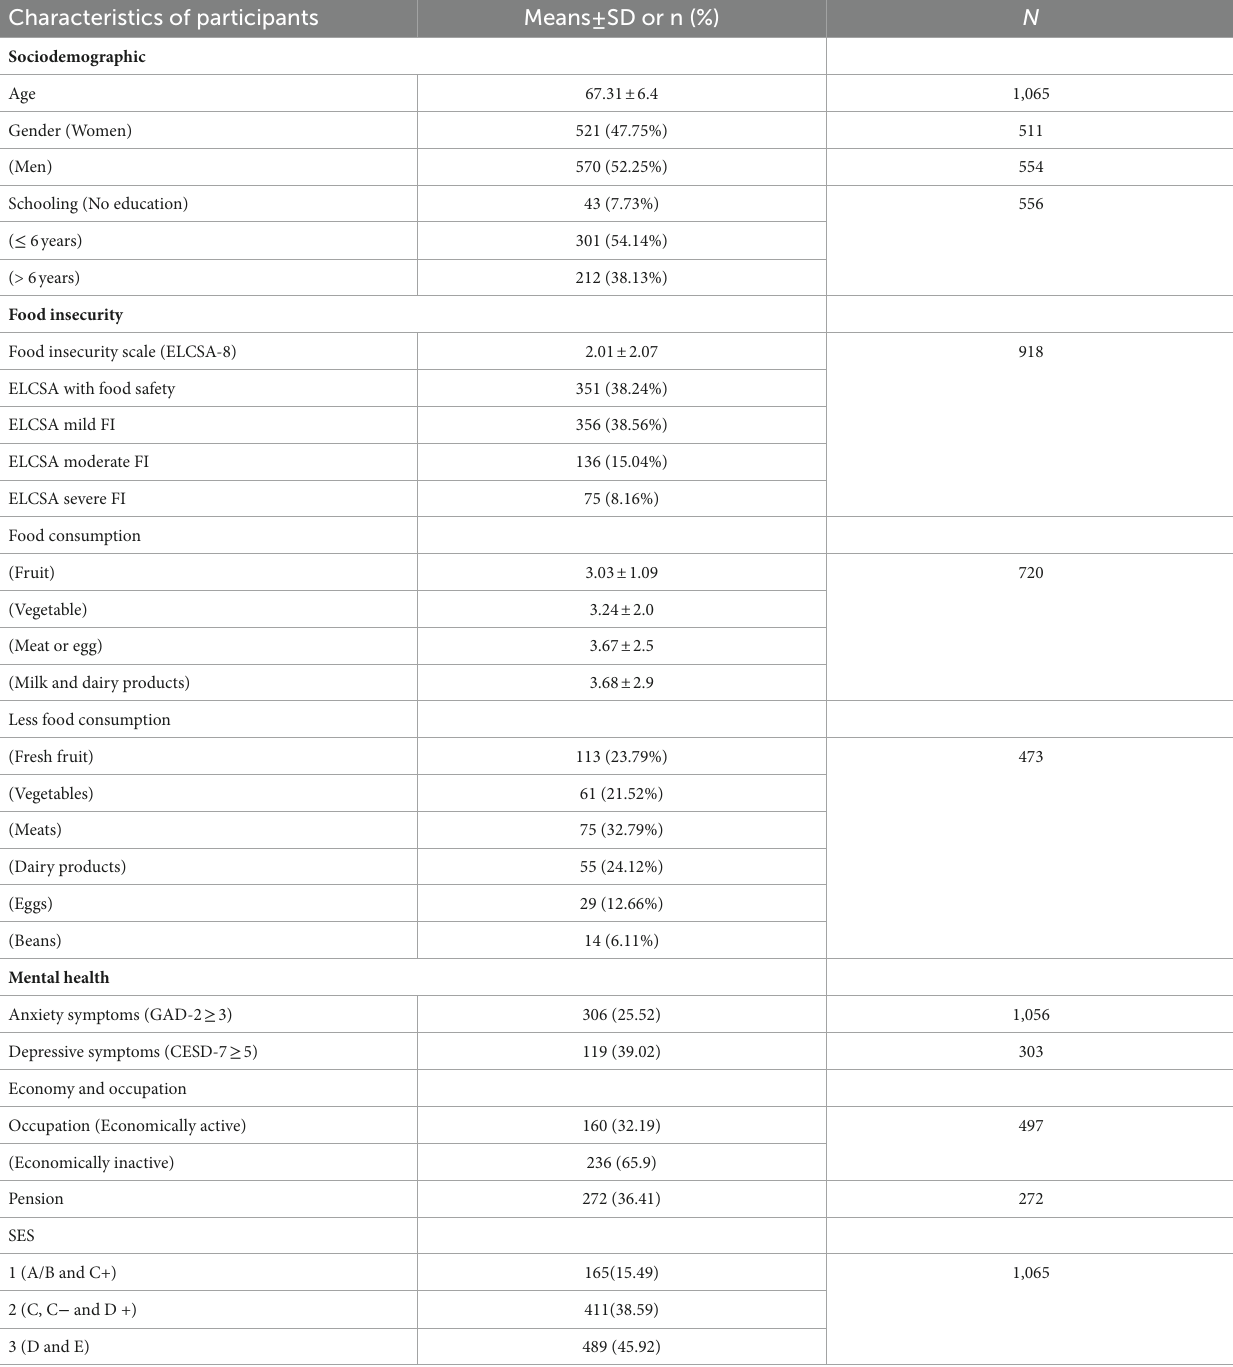
TABLE 1 Description of the characteristics of the study